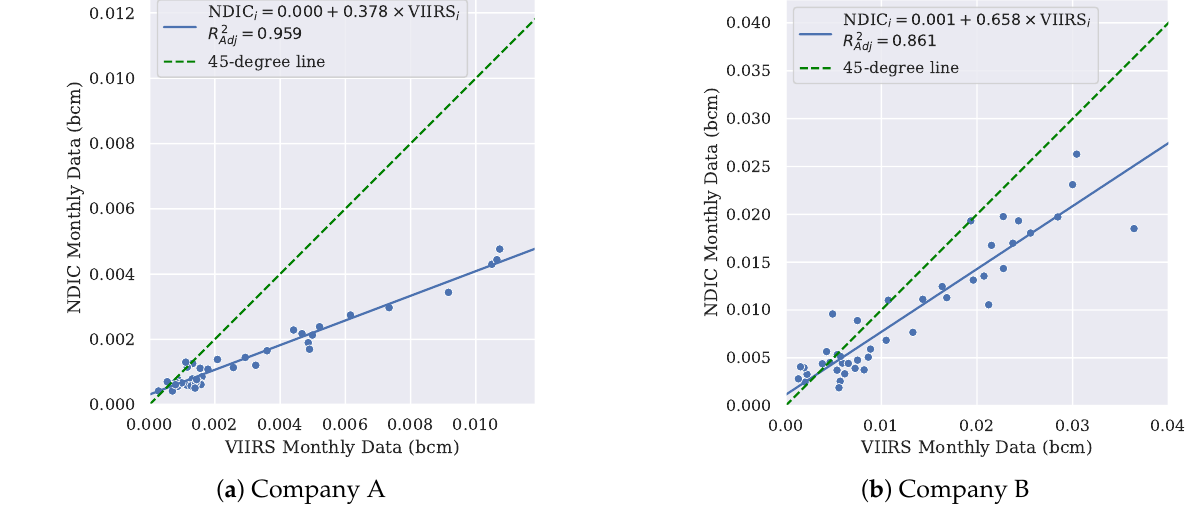
Figure 23. Examples of good fits between the NDIC and VIIRS reported volumes, at the company